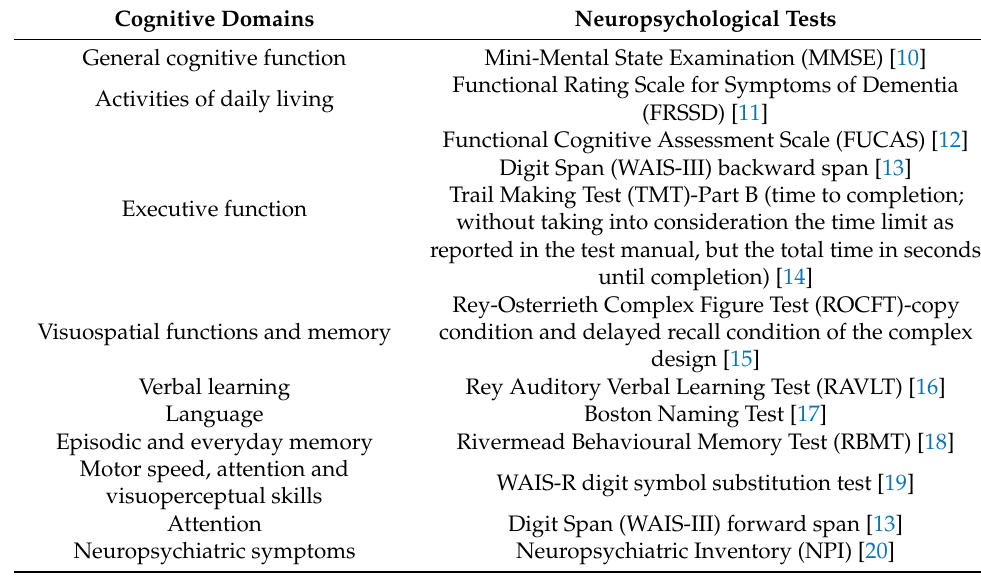
Table 1. Neuropsychological tests and cognitive